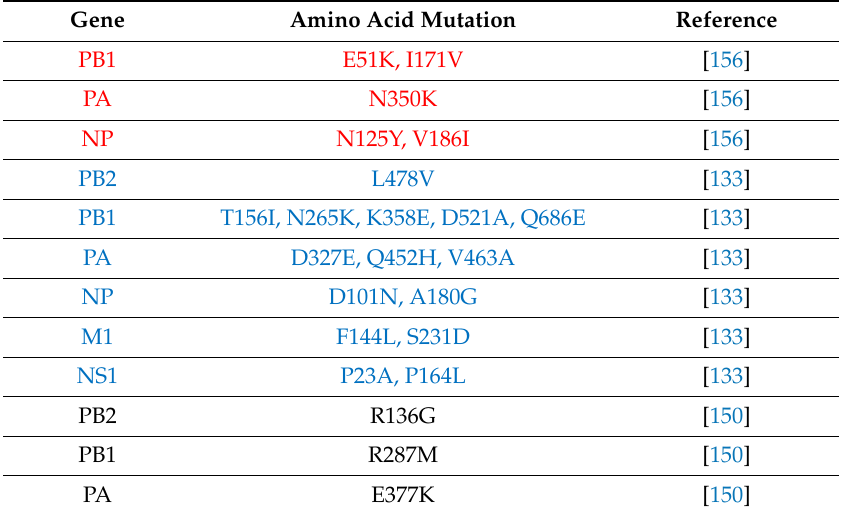
Table 2. Amino acid mutations responsible for the reversion of US MDV A/Ann Arbor/6/60 H2N2 LAIV (red), the Russian MDV A/Leningrad/134/47/57, Len/47 (blue) and WSN (black) to a pathogenic